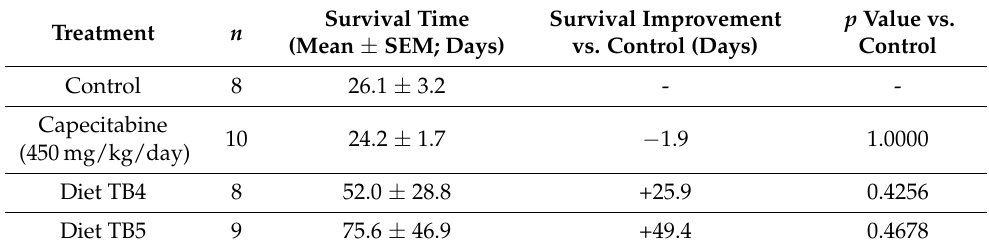
Table 6. Survival of mice with metastatic TNBC treated with diets TB4, TB5 or capecitabine.